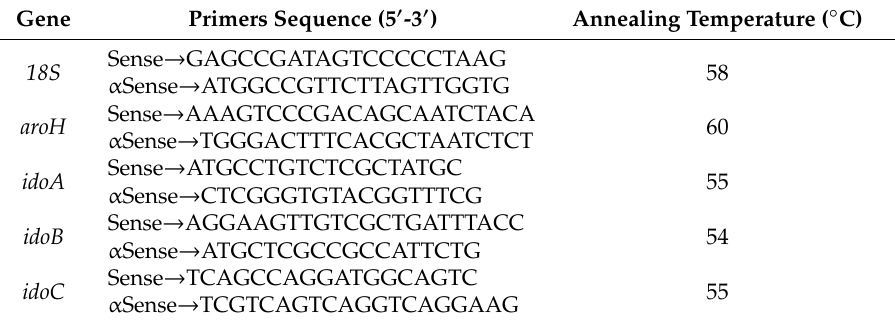
Table 2. qPCR primers used in this